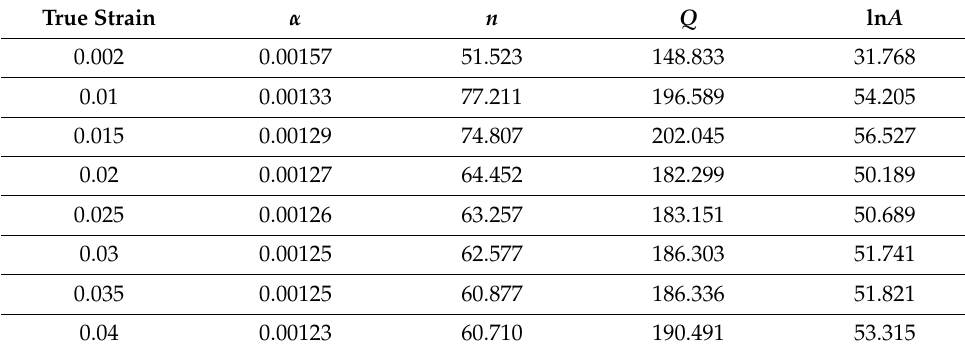
Table 5. Detailed fitted material parameters at different true